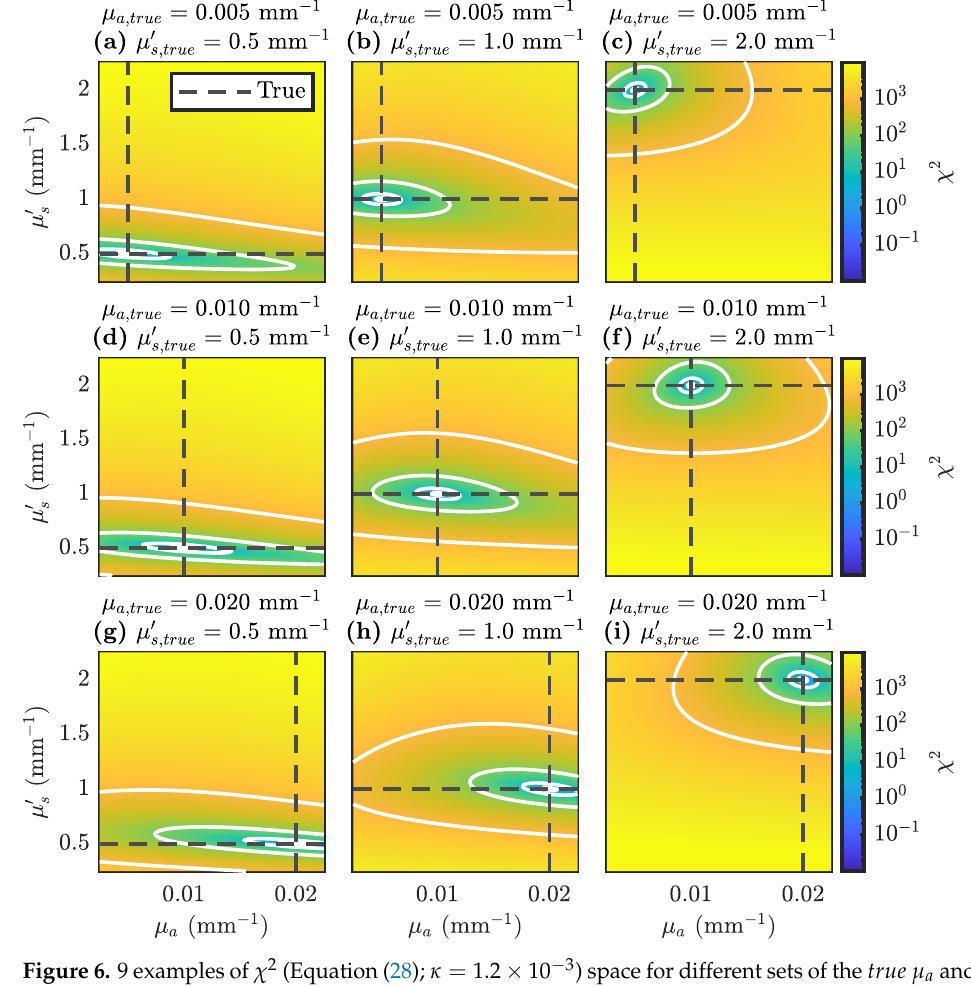
Figure 6. 9 examples of χ 2 (Equation (28); κ = 1.2 × 10 − 3 ) space for different sets of the true µ a and µ (cid:48) s